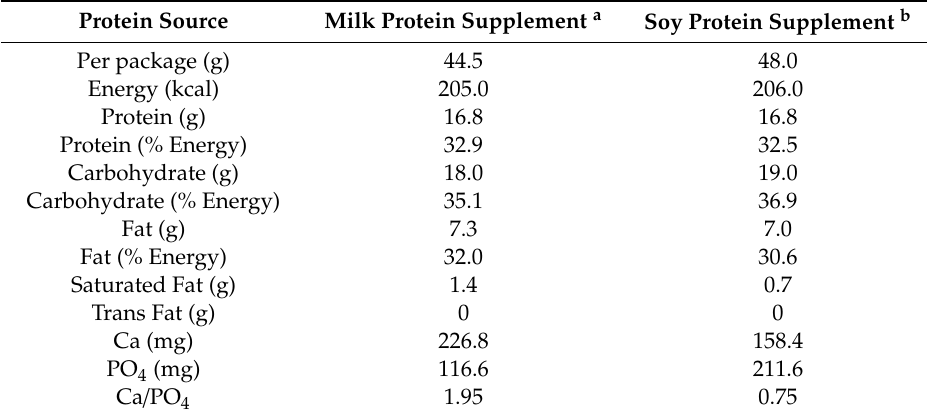
Table 1. Nutritional ingredients in protein nutritional